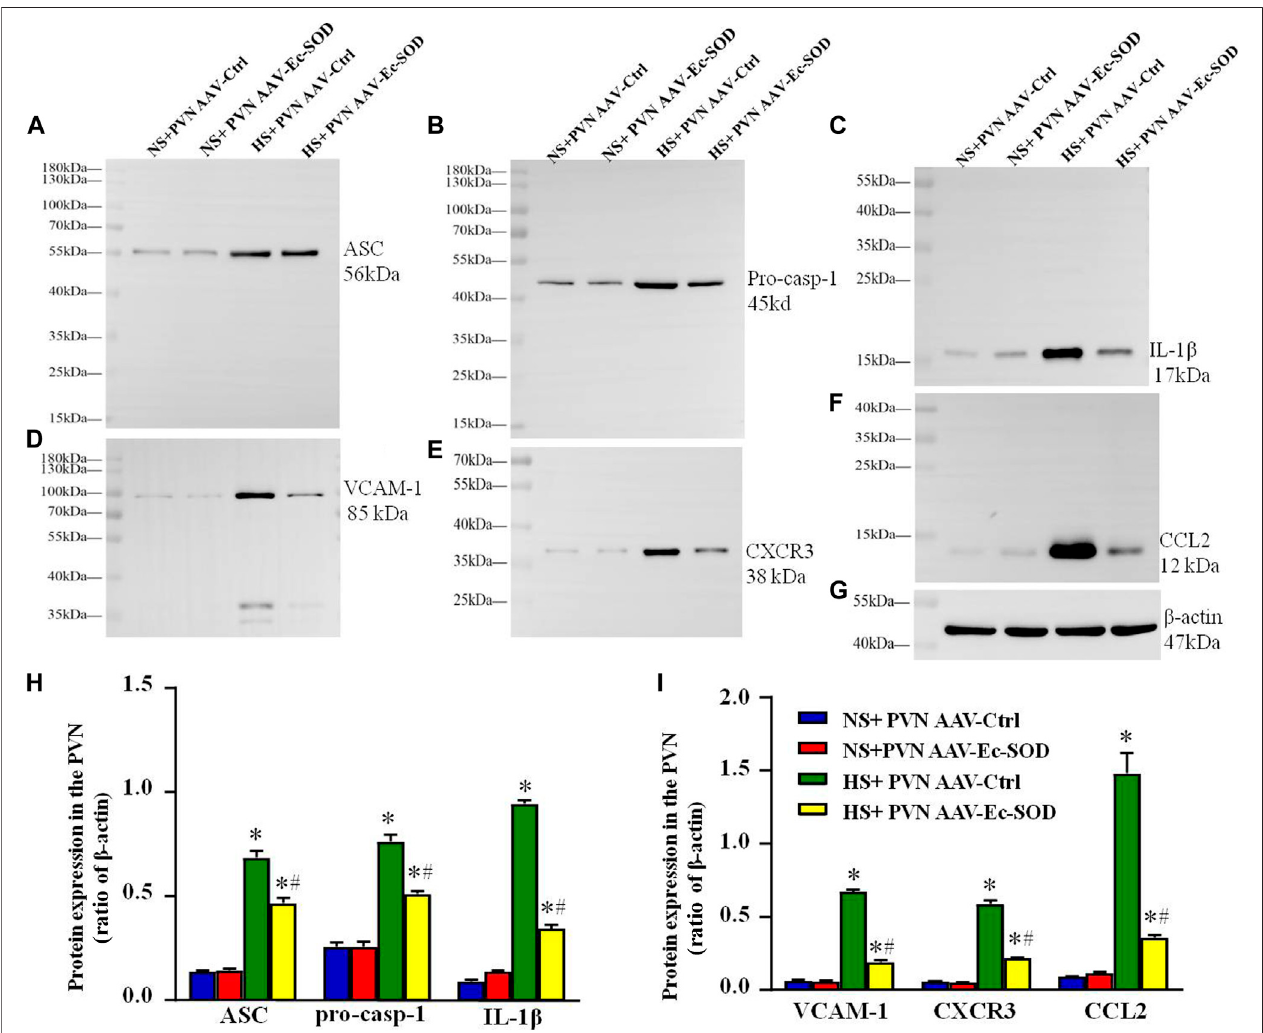
FIGURE5| Effect ofAAV-Ec-SODonthein fl ammationproteins inthePVN. (A – G) Representativeimmunoblotand (H – I) densitometric analysisofPVN expression levelsofASC,pro-casp-1,IL-1 β ,VCAM-1,CXCR3,CCL2,and β -actinindifferentgroups.Valuesareexpressedasmean ± SEM(n (cid:2) 4).* p < 0.05NS+PVNAAV-Ctrl vs. HS + PVN AAV-Ec-SOD; # p < 0.05 HS + PVN AAV-Ctrl vs. HS + PVN AAV-Ec-SOD.